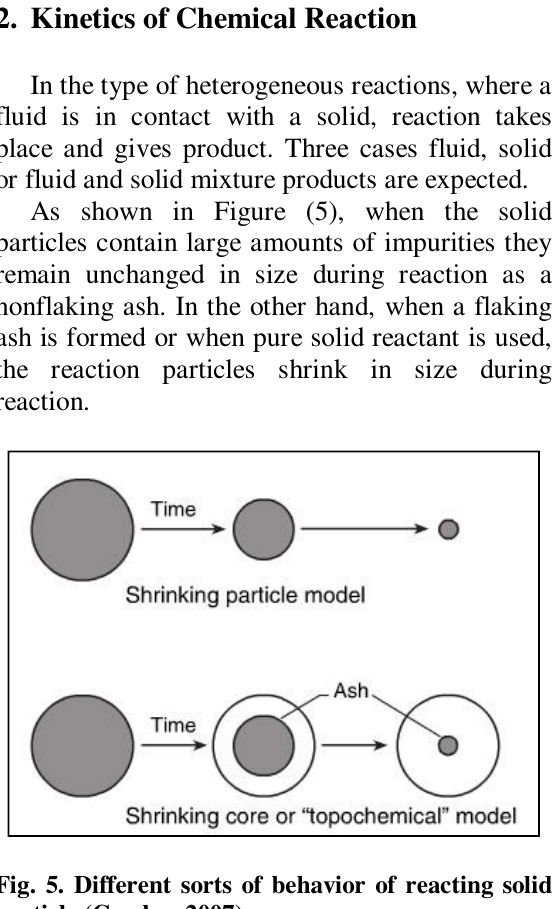
Fig. 5. Different sorts of behavior of reacting solid particle (Cussler,